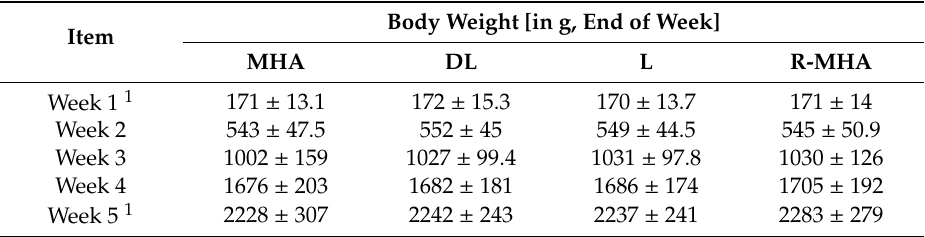
Table 4. Average body weight (BW) during the trial (mean ± standard deviation (SD)). Body Weight [in g, End of Week] Item